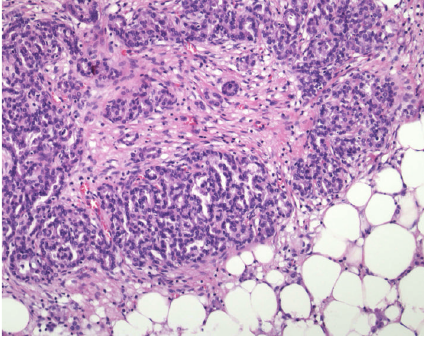
Figure 3: High power view of the lesion demonstrating papillary renal cell carcinoma.